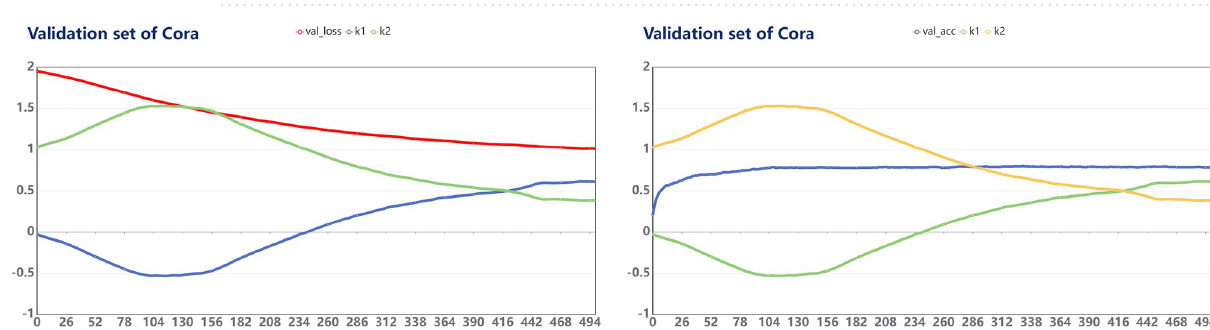
Figure 6. Cora: Fitting relationship between val_acc, val_loss and parameters.